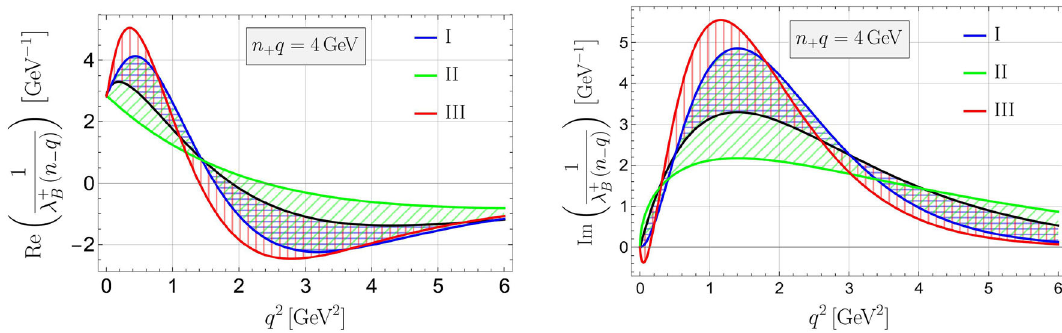
( n − q ) at fixed n + q = 4 GeV for φ I , II , III (ω) in blue, green and red, B